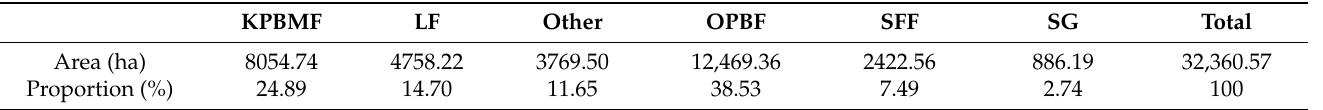
Table 2. The area statistics of tree species in Changbai Mountain Protection Development